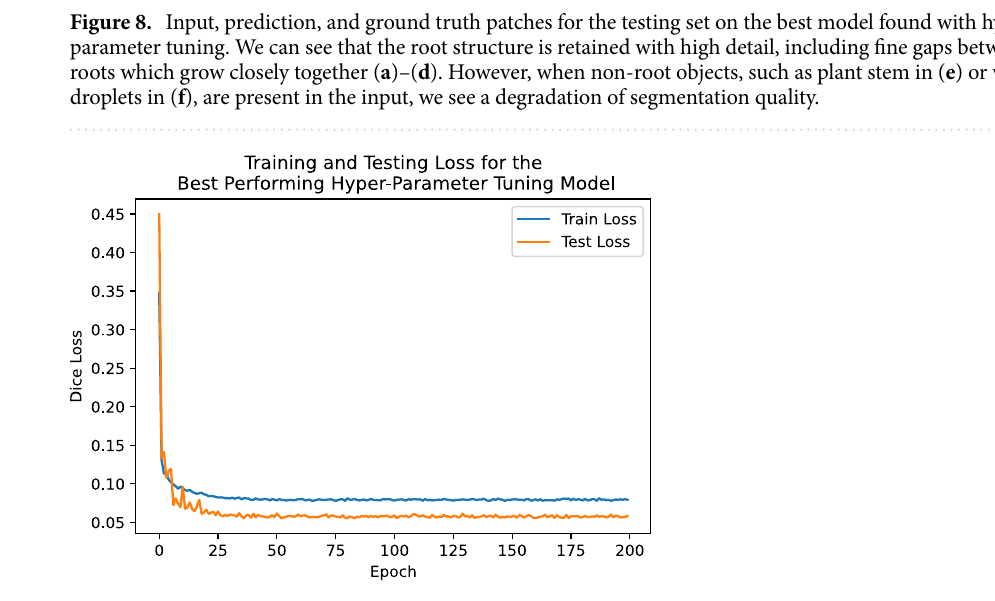
(c) Roots with many gaps and thin areas that are seg- mented.